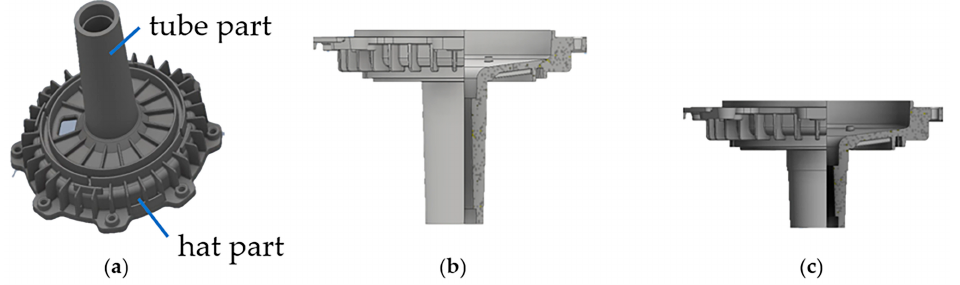
Figure 1. Main parts of the casting ( a ); geometric difference of the Statorbuchse GD 150 casting: ( b ) SB 120; ( c ) SB 55.